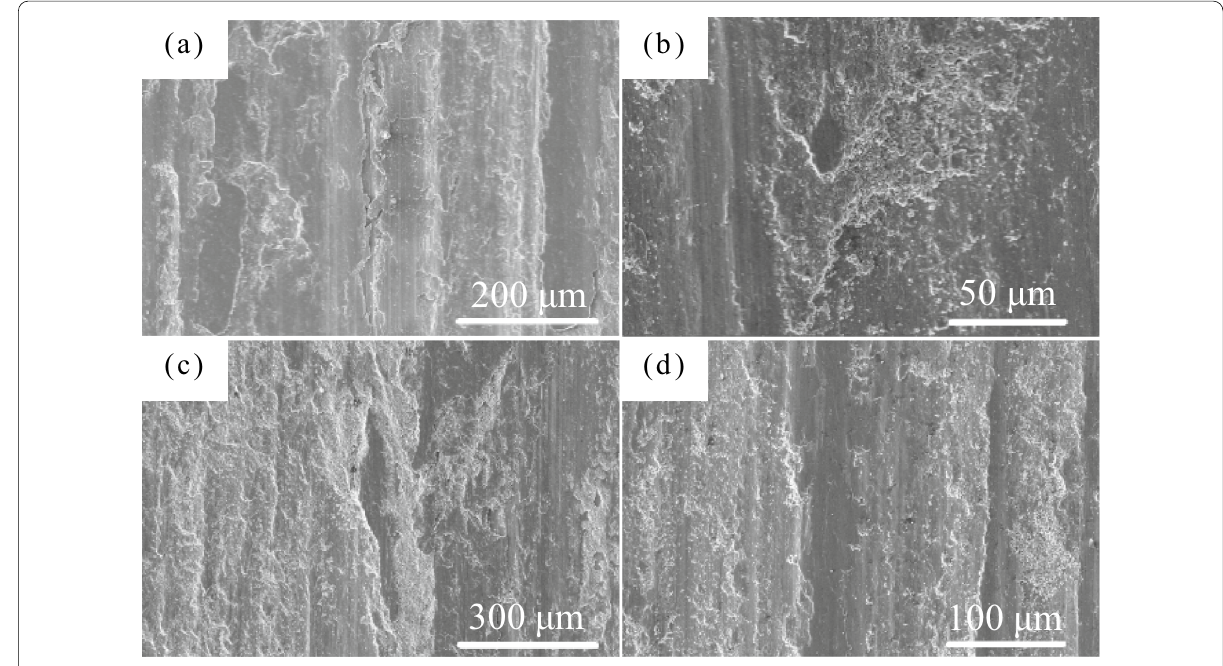
Figure 13 Wear properties of samples: ( a ) Milled, ( b ) T-rolled, ( c ) U-rolling-V, ( d )